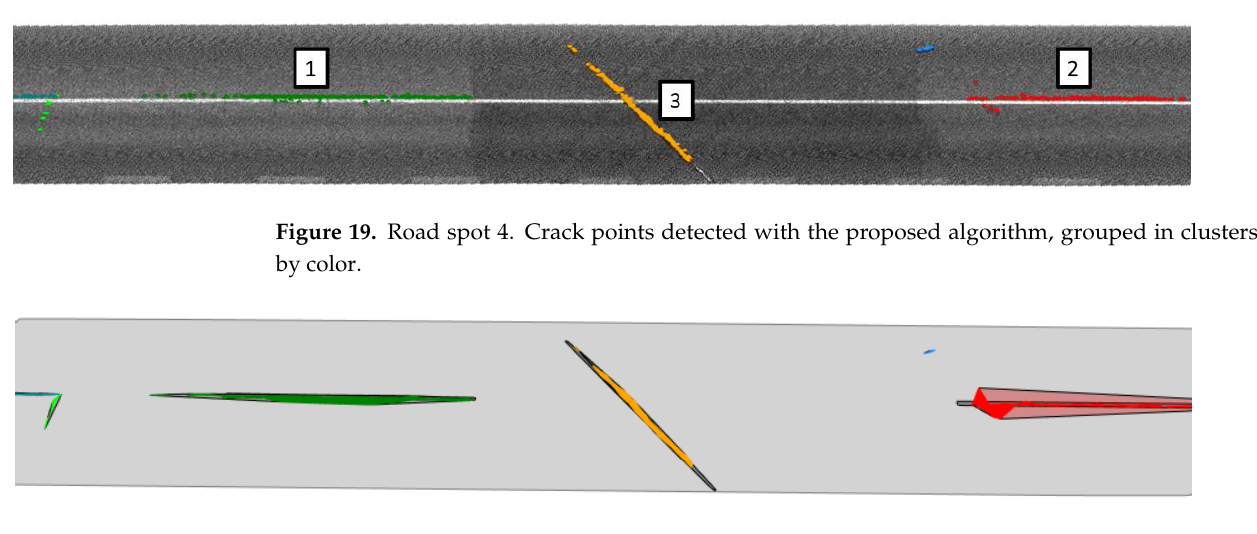
Table 1. Cracks correctly identified by the algorithm at each